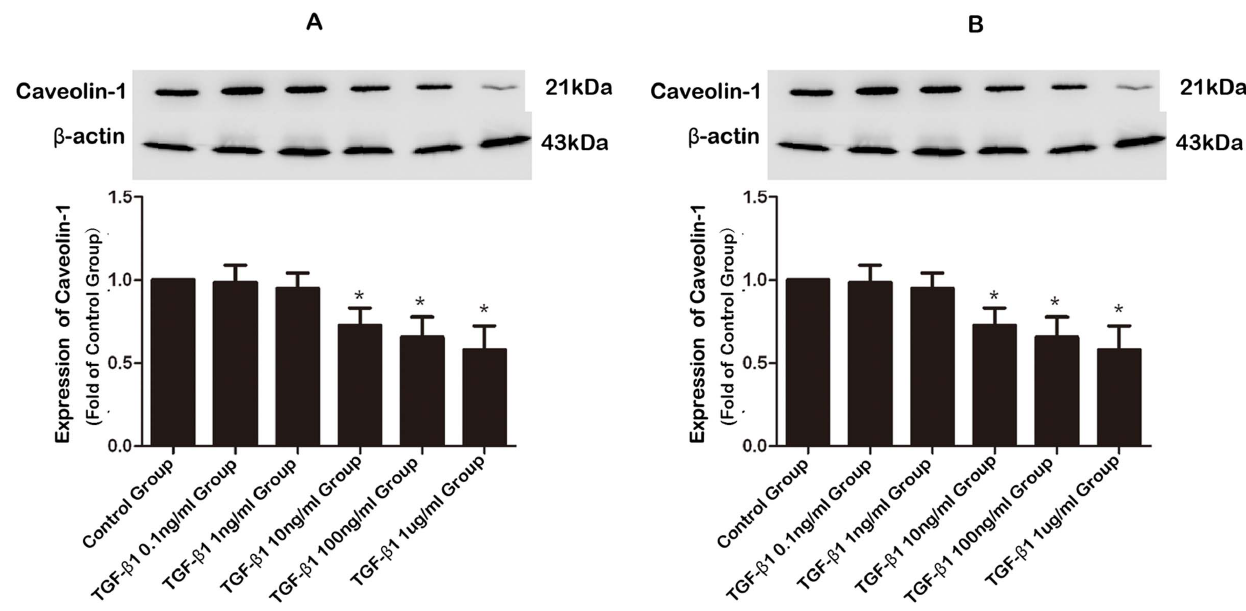
Figure 5. Effects of TGF- b 1 on the expression of Cav-1 in human atrial fibroblasts (HAF). A , Time-dependent alterations of Cav-1 protein levels assessed by Western blotting in HAFs incubated with TGF- b 1 of 100 ng/ml for varying periods (0, 6, 12, 24, and 48 h). Note that TGF- b 1 induced bi-phasic changes of Cav-1 protein expression with initial upregulation followed by subsequent downregulation. Control HAFs were mock-treated. B , Concentration-dependent effects of TGF- b 1 on Cav-1 protein levels assessed by Western blot analysis in HAFs exposed to varying concentrations of TGF- b 1 (0, 0.1, 1, 10, 100, and 1000 ng/ml) for 48 h. *P , 0.05 vs. Control; n=3 per group with each measurement conducted in triplicate.